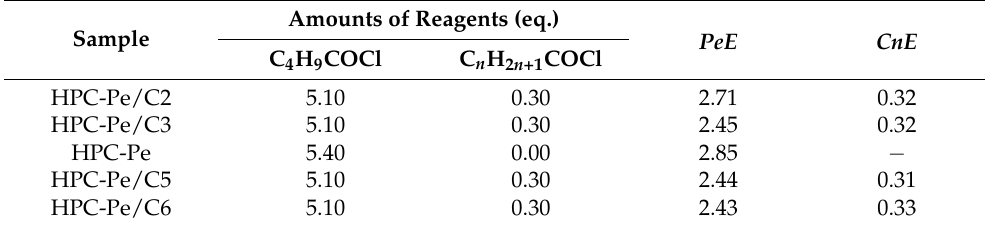
Table 3. Feed amounts of alkanoyl chlorides used in the syntheses of HPC-Pe/C n , and the number of the hydroxy groups substituted by C 4 H 9 COCl and C n H 2 n +1 COCl per anhydroglucose unit, denoted as PeE or CnE , respectively, determined by 1 H-NMR spectra. The amounts of reagents are expressed in the unit of equivalents relative to the number of anhydroglucose units in 2.00 g of HPC. Amounts of Reagents Sample